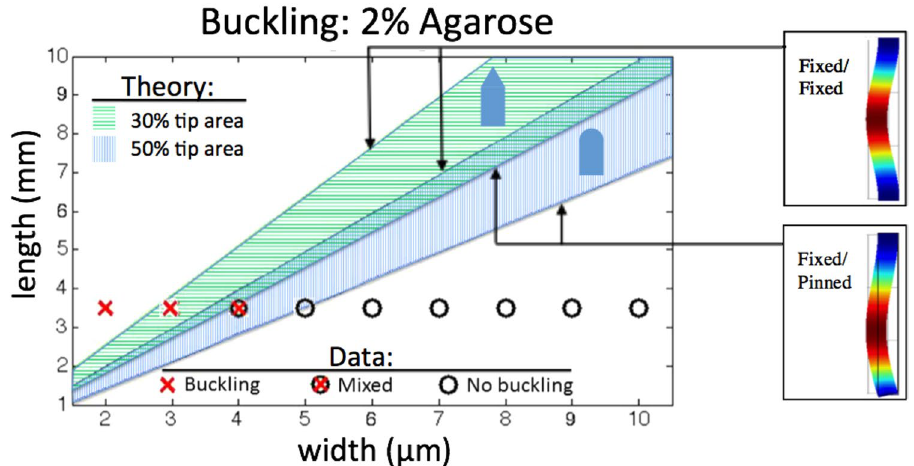
Figure 4. Maximum Photonic Needle lengths above which buckling occurs (for a range of widths). The range of waveguide lengths derived from theory assumes the boundary conditions are somewhere between fixed/fixed and fixed/pinned for the inserted waveguides with both pointed and rounded tips. ( , respectively) Dimensions were extracted from our experiments for buckling and no buckling conditions ( , respectively). The mixed point ( ) represents dimensions where the rounded tip needle ( ) buckled and the pointed tip needle ( ) did not buckle. Right are finite element (FEM) rendered beams buckling for fixed/pinned and fixed/fixed boundary conditions (not to scale). Arrows point to the curves describing each boundary condition assumption enclosing the theoretical range of critical dimensions for each tip